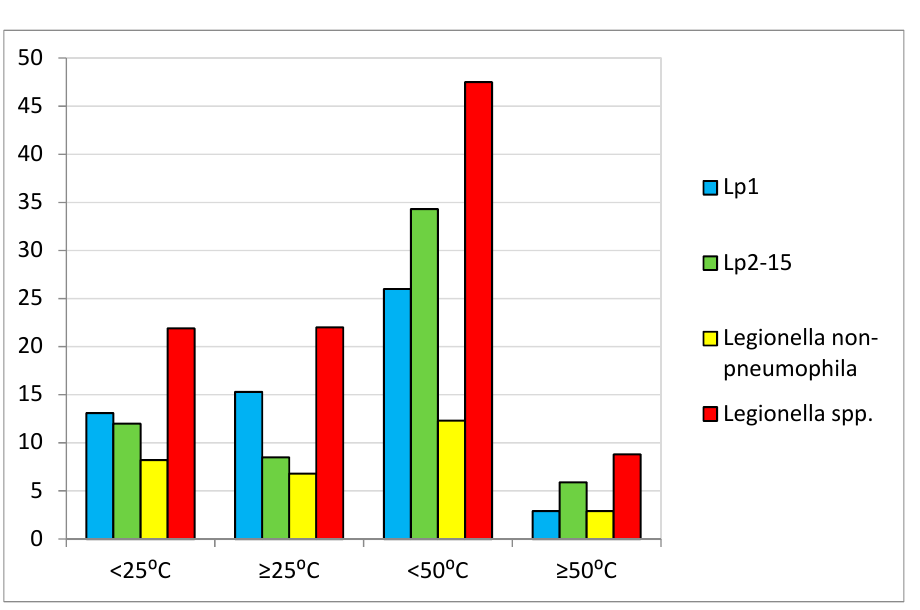
Table 2. Correlation between water temperature and Legionella detection. CIs—confidence intervals. Parameter